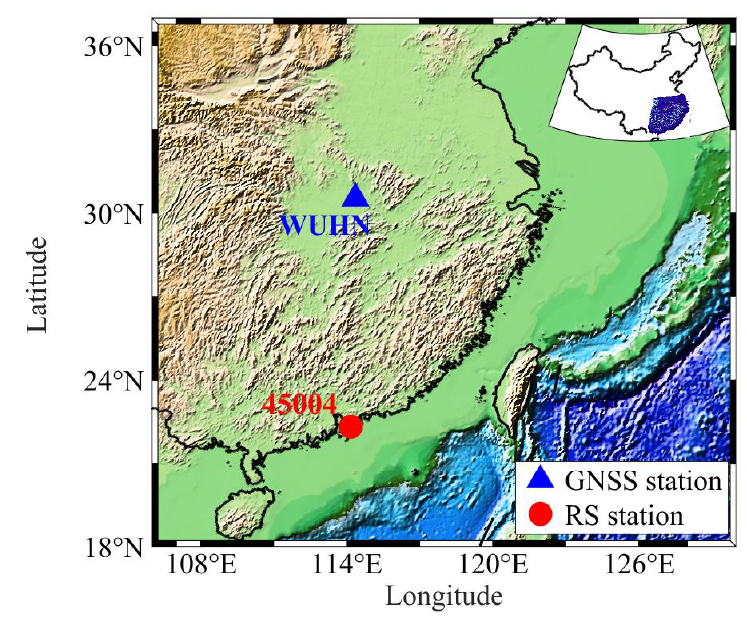
Figure 1. Geographical distribution of Global Navigation Satellite System (GNSS) radiosonde (RS) stations in Southeast China, where the solid blue triangle and red circle are the WUHN and 45005 stations, respectively. Table 1. Characteristics of the datasets selected in the experiment.